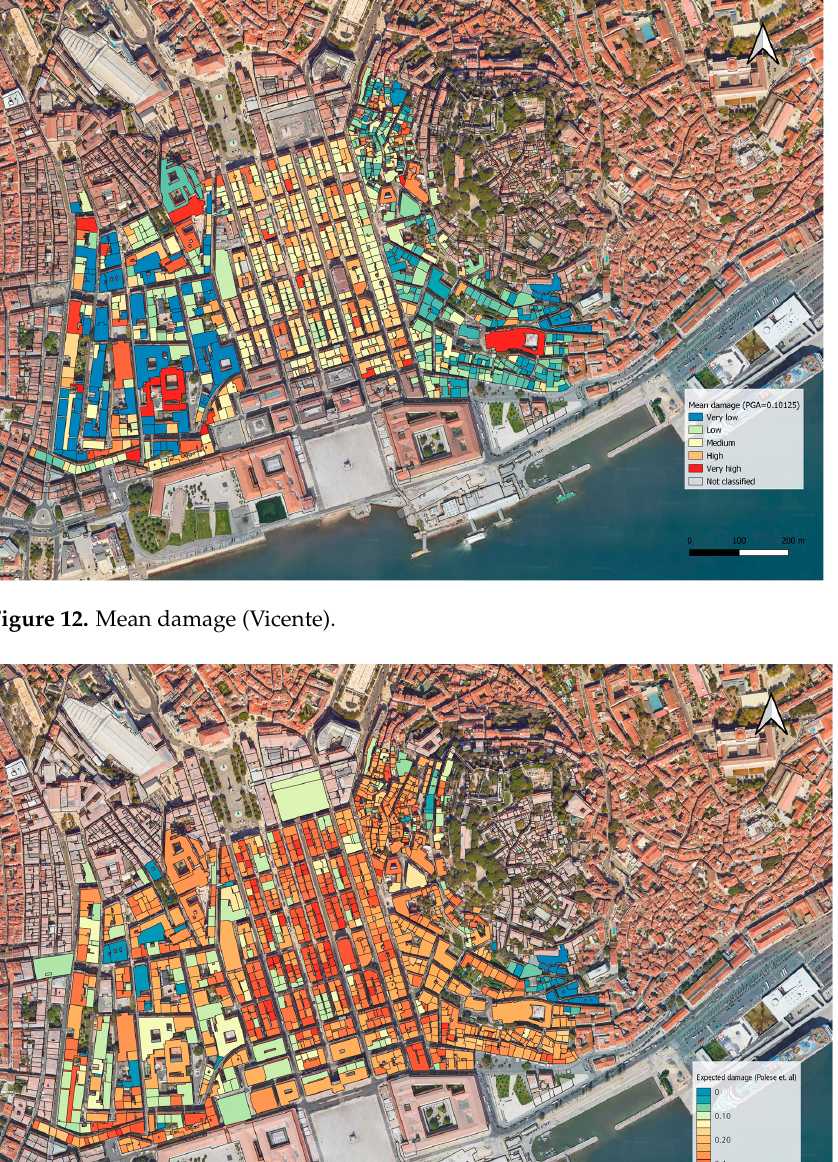
Table 7. Total losses.